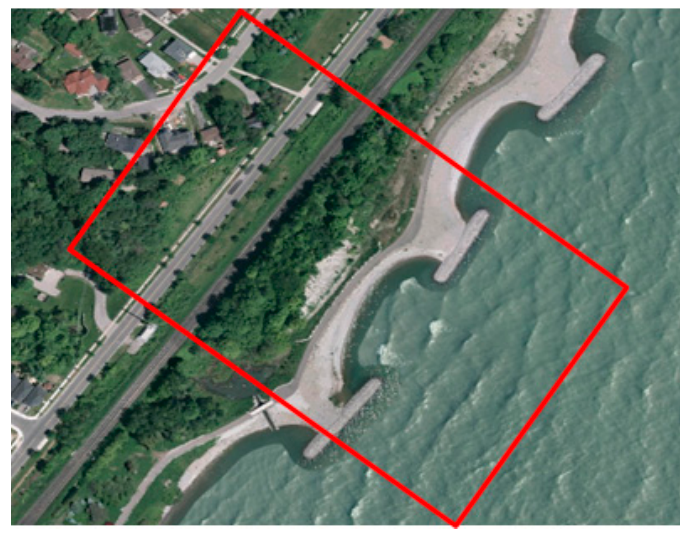
Figure 1. An image of the study area. The red rectangle indicates the LiDAR data coverage.